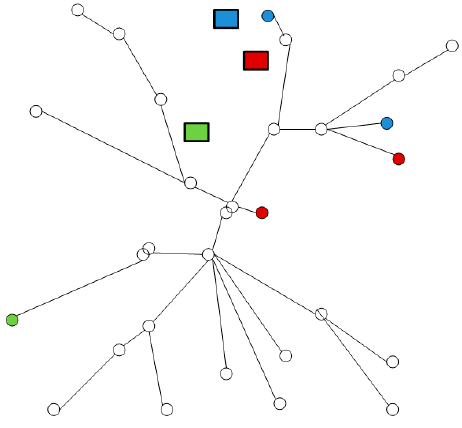
Figure 30. Data collection path of MWST.